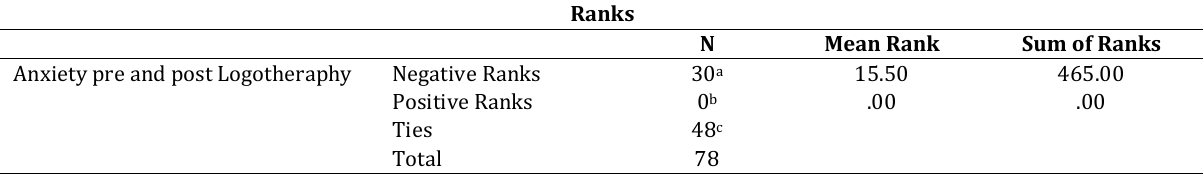
Table 5. Results of output rank Effect of Logotherapy Paradoxical Intention Session 1 Against Anxiety Prisoners in Class II A Penitentiary in Kediri City